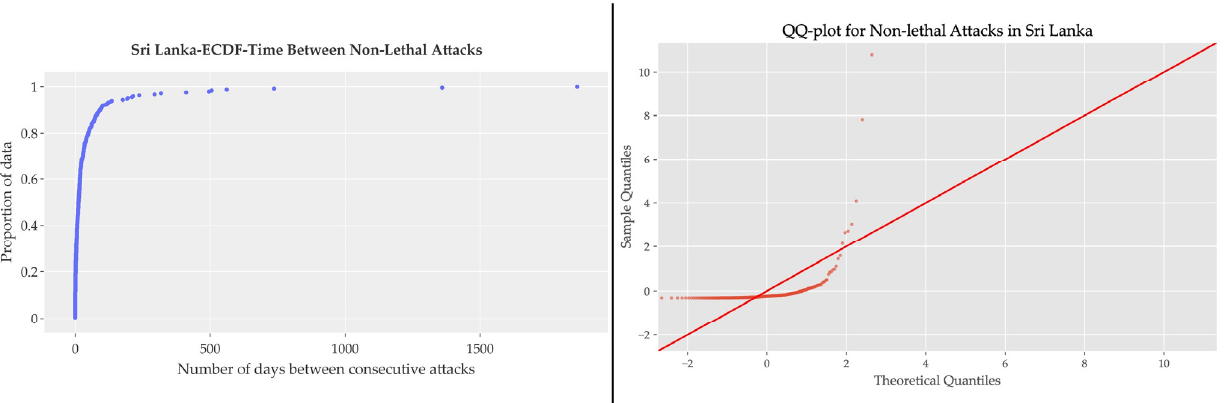
Figure 19. The time between consecutive non-lethal attacks and the corresponding QQ plot for Sri Lanka.